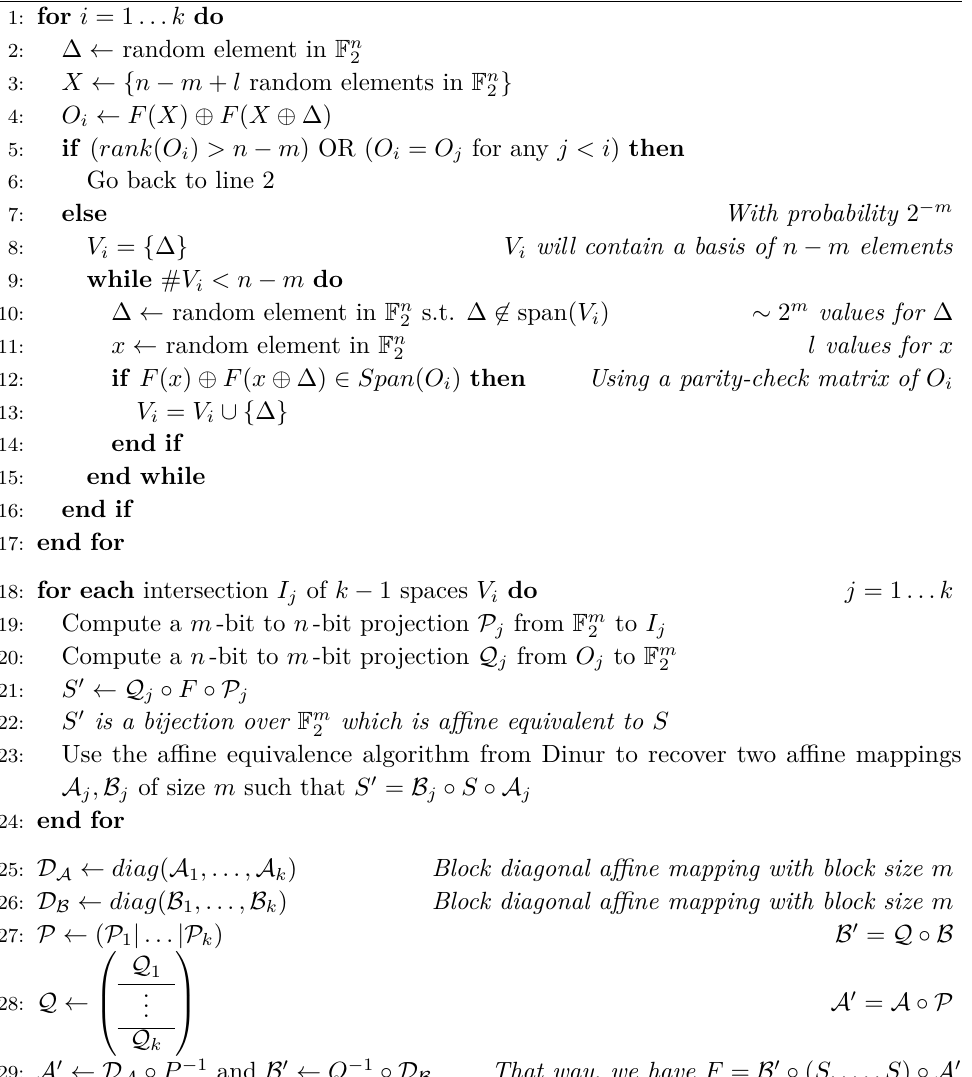
Algorithm 1 Computing e A and e B